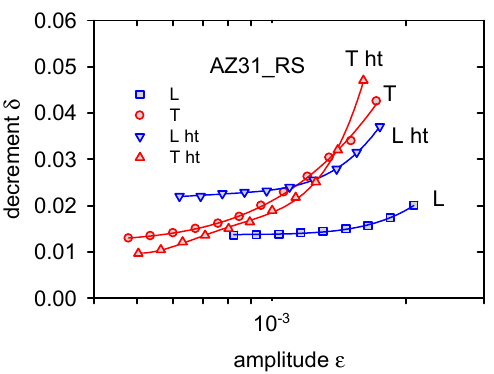
Figure 6. Amplitude dependent decrement estimated for two orientations of AZ31_RS samples in the as-received state and after heat treatment (ht).